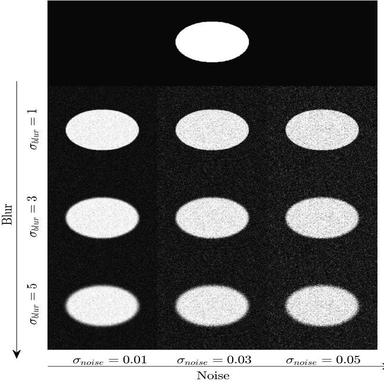
2-D slices of ellipsoids for various levels of blur and noise.